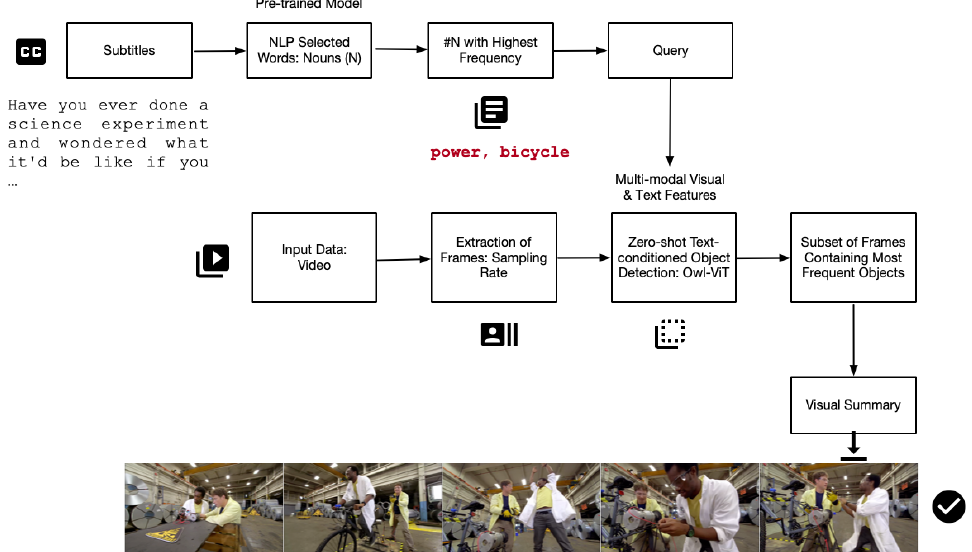
Figure 2. Video Summarization via Zero-shot Text-conditioned Object